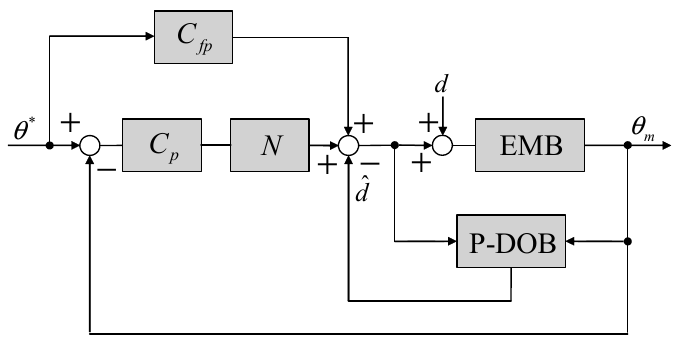
Figure 7. Experimental results for a CFO.